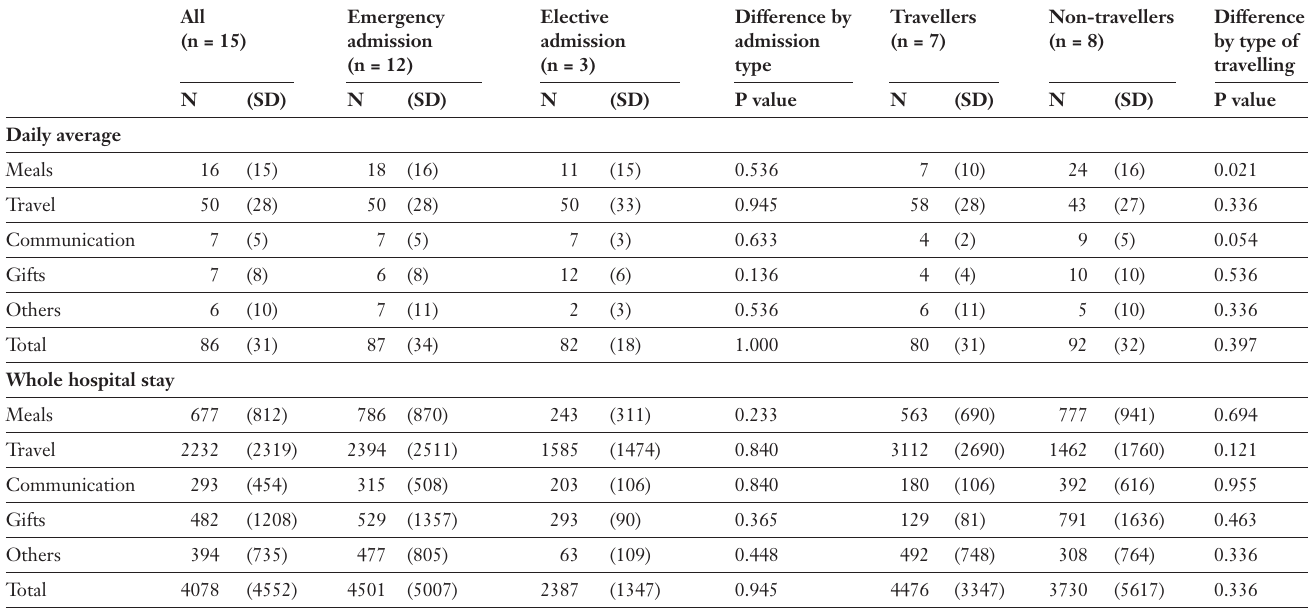
Out-of-pocket expenses for family (CHF), by type of costs, for the whole group, by type of admission and by type of decision about